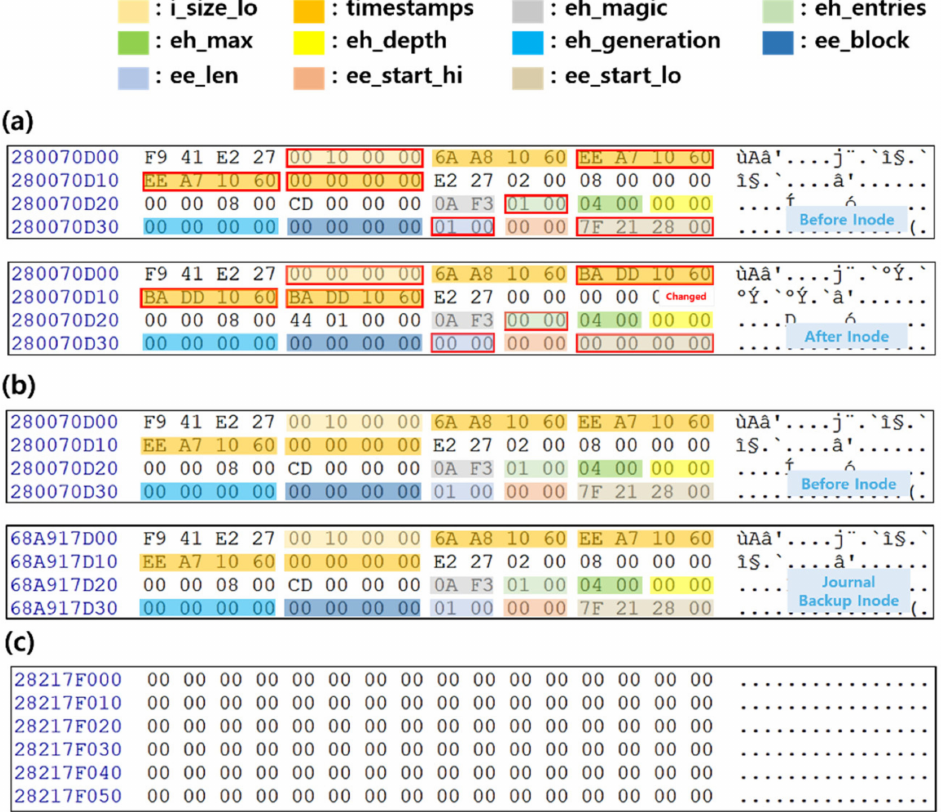
Figure 7. Metadata analysis of filesystem before and after Facebook Messenger data deletion using scenario II ( a ) Comparison of /data/data/com.facebook.orca/database’s inode before and after delet- ing app data ( b ) Comparison of /data/data/com.facebook.orca/databases’s inode before deletion and journal backup inode ( c ) Database directory entries searched based on journal backup